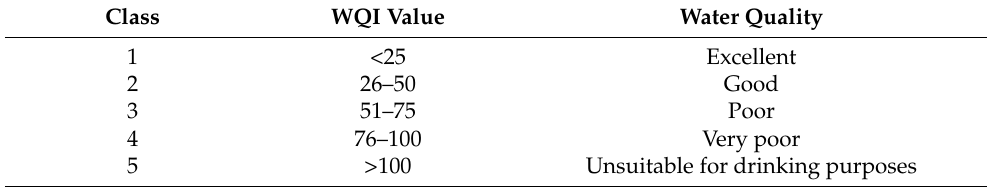
Table 1. Classification of groundwater quality according to the water quality index (WQI) values. Class WQI